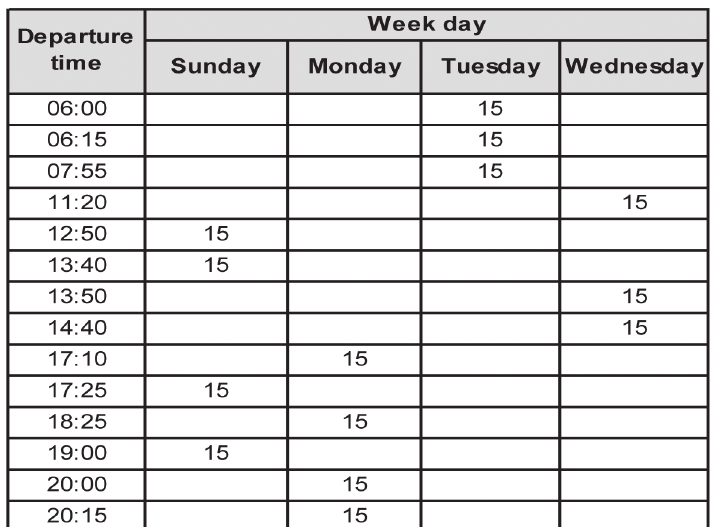
Table 2: Sample framework at